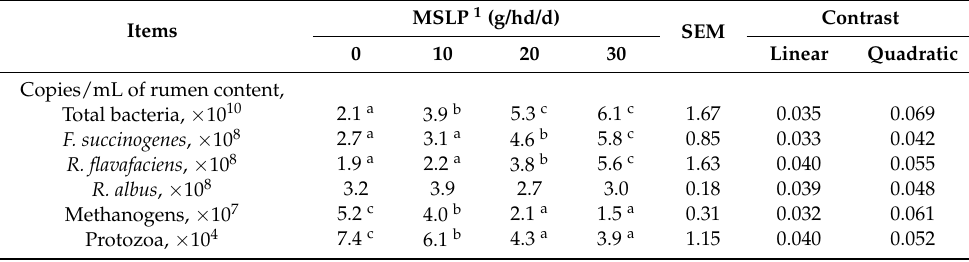
Table 4. Effect of Mitragyna speciosa Korth leaf pellet supplementation on microbial population in Thai native beef cattle. Contrast MSLP 1 (g/hd/d) Items SEM 0 10 20 30 Linear